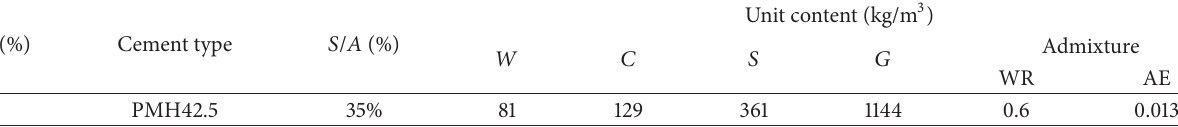
Table 2: Mix proportion of dam concrete.